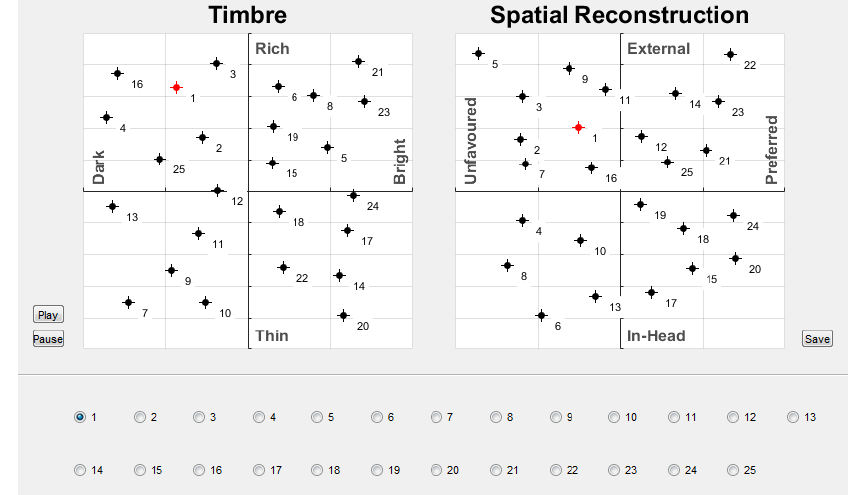
Figure 9. The graphical interface used by participants to rate audio stimuli. Selection of stimuli was made using the radio buttons at the bottom of the interface. A corresponding marker would be highlighted on each graph and participants were required to click and drag the markers using a computer mouse to where they felt was